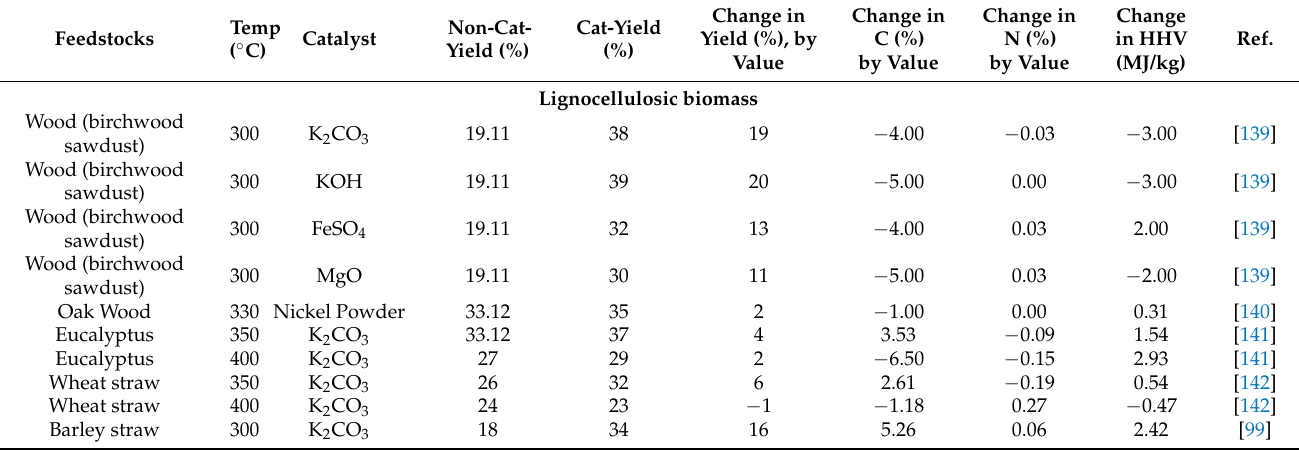
Table 5. Effect of temperature and catalyst on biocrude yield and